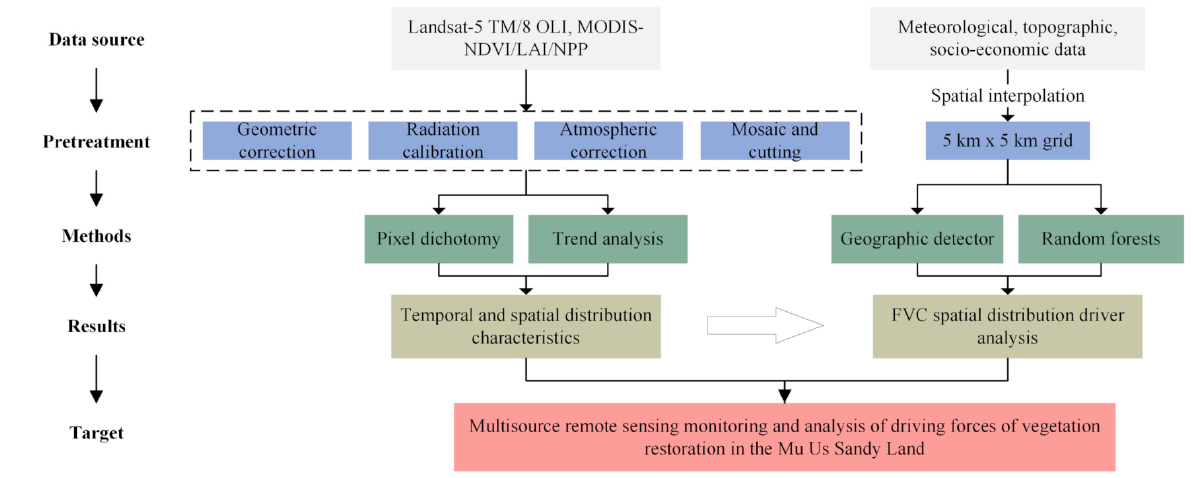
Figure 2. Flowchart of the overall methodology used in this